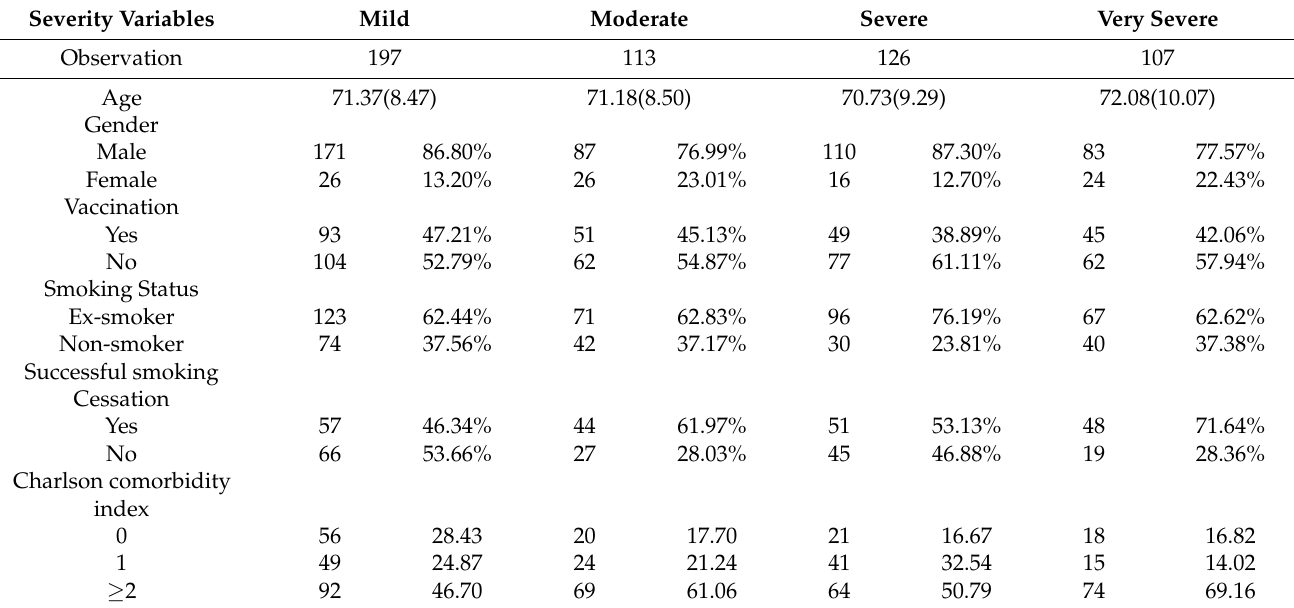
Table 1. Demographic characteristics of the study